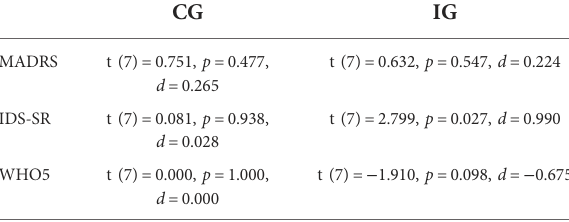
TABLE 4 Statistical analysis of the pre-training phase (t0t1). CG IG